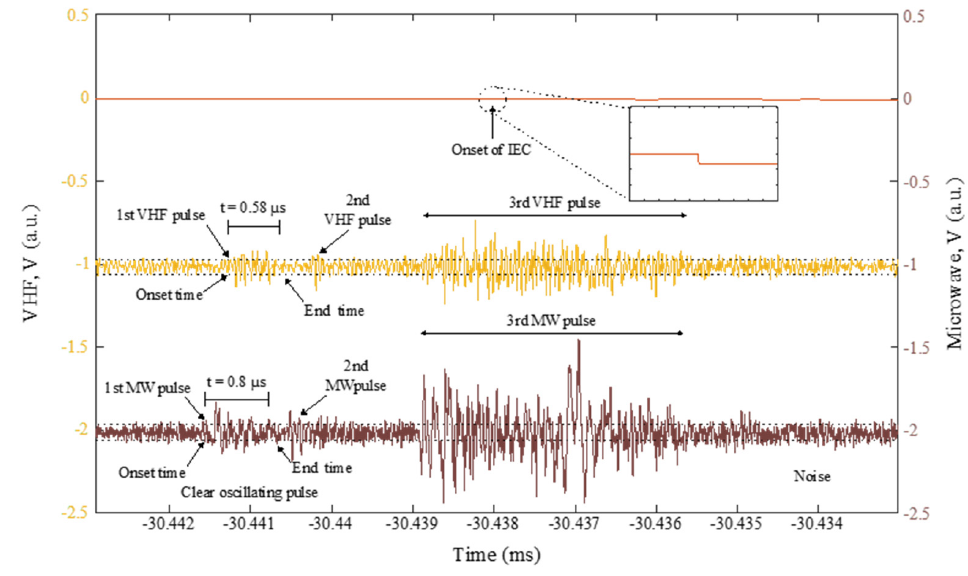
Figure 4. A detailed zoom-in of the first microwave and VHF radiation pulses detected (increased scale from Figure 3) where red line for SA, gold for VHF sensor and brown for microwave sensor. [Sampling rate: 2.5 GS/s for microwave, 250 MS/s for SA, VHF].